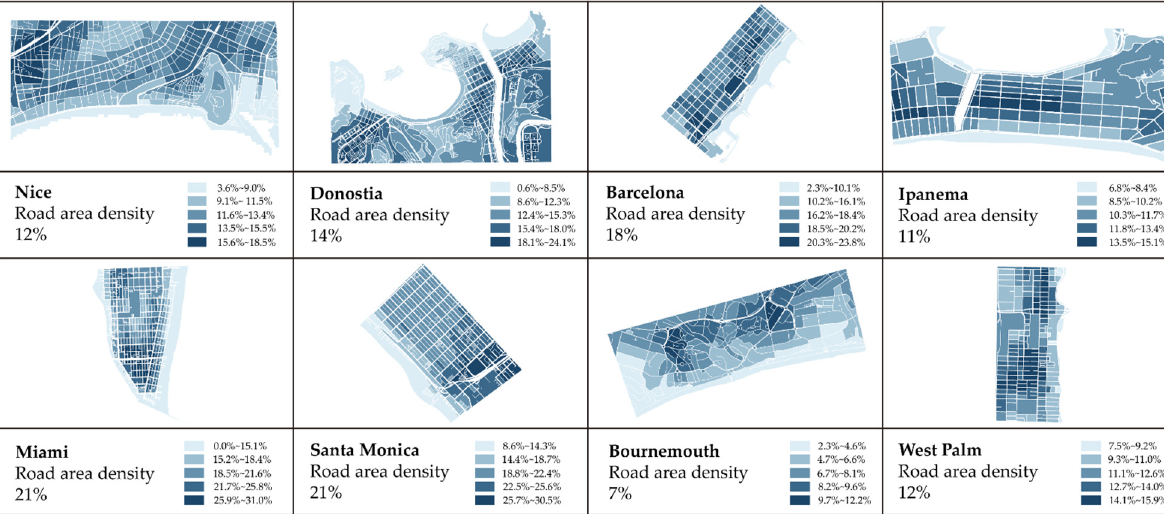
Figure 4. The visualization results of road area density in successful coastal cases.